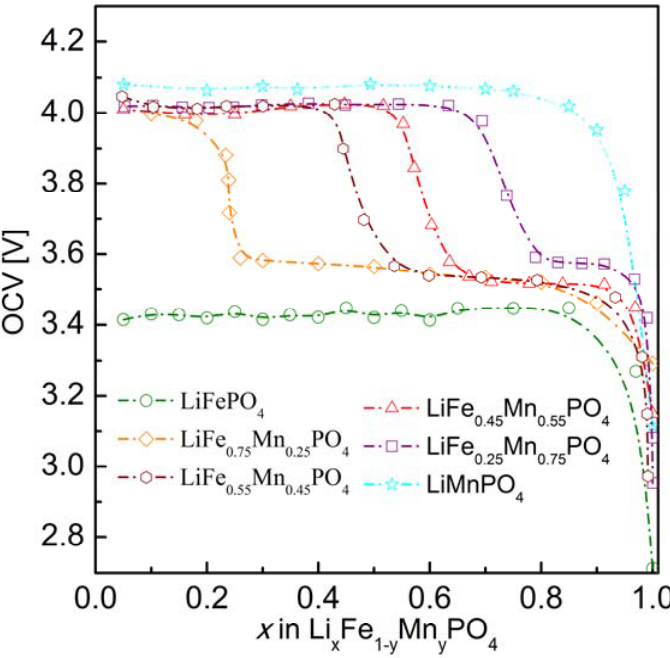
Figure 26. OCV curves for Li/Li + /Li and 1)